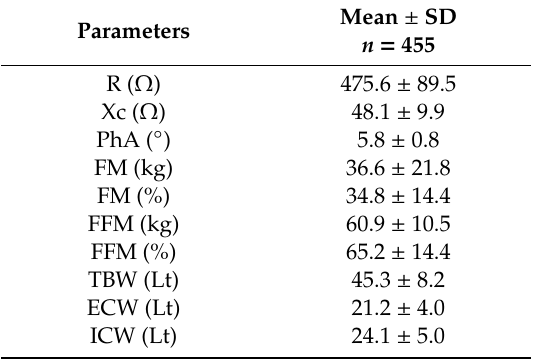
Table 2. Body composition parameters of the study